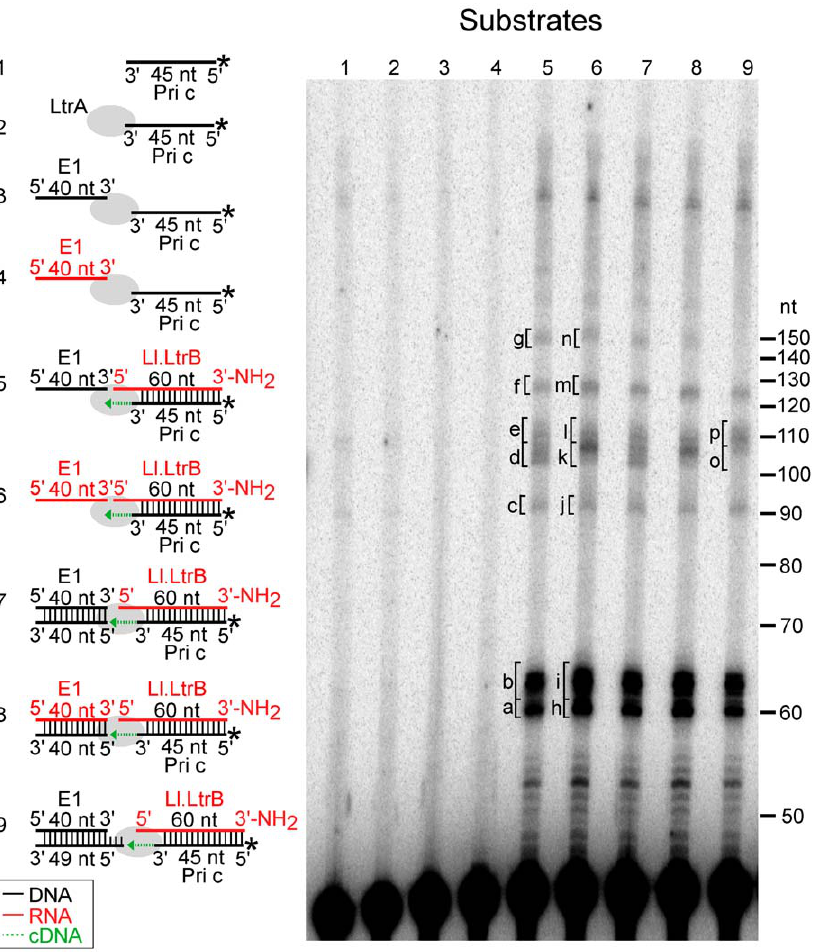
Figure 6. Template switching of LtrA from the 5 9 end of the Ll.LtrB intron RNA to exon 1 DNA or RNA. The Ll.LtrB intron RT (LtrA protein; 40 nM) was incubated with artificial substrates corresponding to the 5 9 end of Ll.LtrB intron (Ll.LtrB RNA; 40 nM) with an annealed 5 9 - 32 P-labeled DNA primer c (Pri c; 44 nM) in presence of exon 1 (E1) DNA or RNA (40 nM; black and red, respectively), as diagrammed in schematics to the left of the gel. The substrates were incubated with dNTPs (200 m M) in reaction medium containing 450 mM NaCl, 5 mM MgCl 2 , 20 mM Tris-HCl, pH 7.5, and 1 mM DTT for 30 min at 30 u C. After terminating the reaction by extraction with phenol-CIA, the products were analyzed in a denaturing 15% polyacrylamide gel. Lanes (1) and (2) 32 P-labeled Pri c incubated without and with LtrA, respectively; (3) and (4) LtrA incubated with 32 P-labeled Pri c and E1 DNA or RNA, respectively; (5) and (6) LtrA incubated with Ll.LtrB RNA with annealed 32 P-labeled Pri c and E1 DNA or RNA, respectively; (7–9) LtrA incubated with Ll.LtrB RNA with annealed 32 P-labeled Pri c and E1 DNA or RNA with annealed complementary DNA oligonucleotides to leave a blunt end (exon 1 AS) or a 5 9 -bottom-strand overhang (exon 1 AS + 9). Bands excised for sequencing (Figure 7) are indicated in the gel. In the schematics, DNA and RNA oligonucleotides are shown in black and red, respectively; LtrA is shown as a gray oval; and the direction of cDNA synthesis is indicated by a green arrow. The numbers to the right of the gel indicate the positions of 5 9 -end labeled size markers (10-bp DNA ladder,